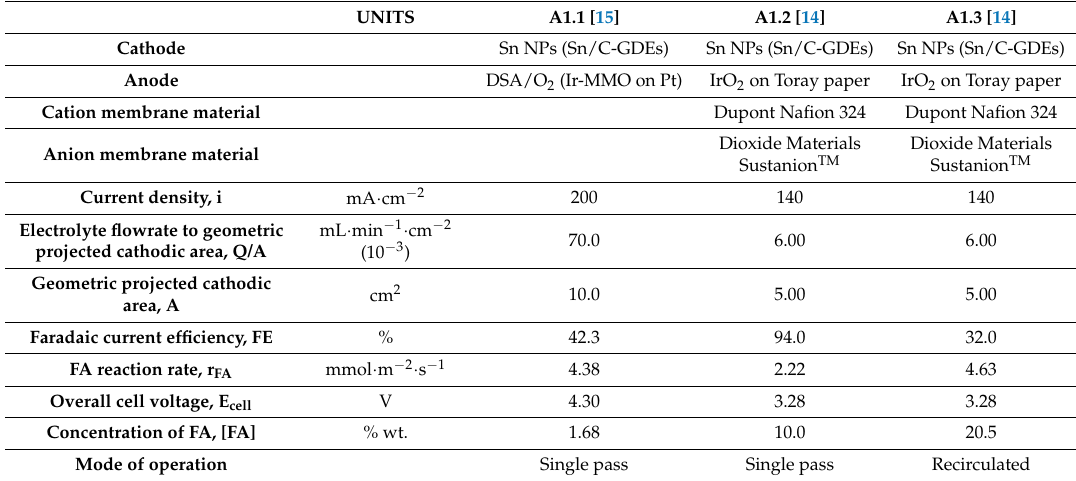
Table 2. Experimental conditions of the selected references/scenarios for the carbon footprint of CO 2 to formic